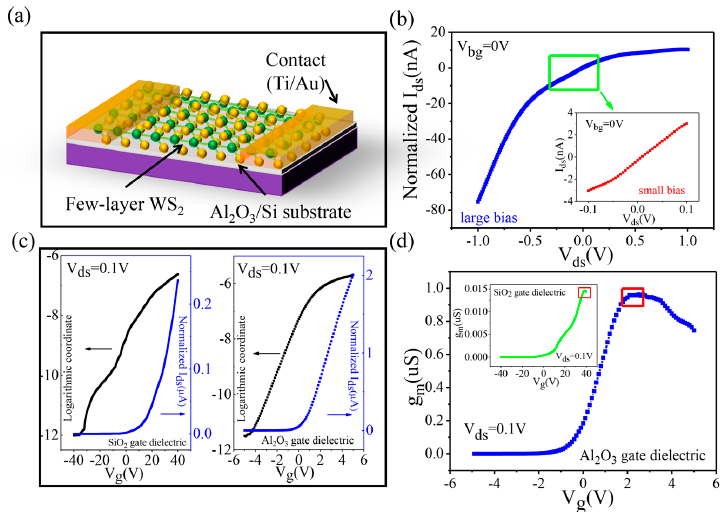
Figure 6. ( a ) Three-dimensional schematic view of the few-layer WS 2 FETs. ( b ) Output characteristics of few-layer WS 2 on Al 2 O 3 /Si substrates in large bias and (inset) small bias voltage. ( c ) Transfer characteristics of few-layer WS 2 FETs on different substrates. ( d ) g m – V g curves of few-layer WS 2 FETs on different substrates.